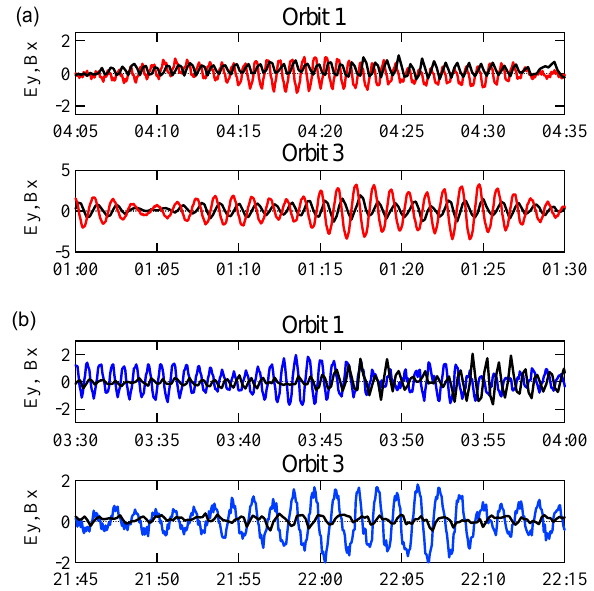
Figure 6. Van Allen Probes A (plotted in red) and B (plotted in blue) observations of electric and magnetic fields on orbits 1 and 3 show that E y (plotted in black) lags B x by 90 ◦ indicating that the Pc4 pulsations are second-harmonic mode poloidal oscillations. E y and B x are displayed in mVm − 1 and nT,